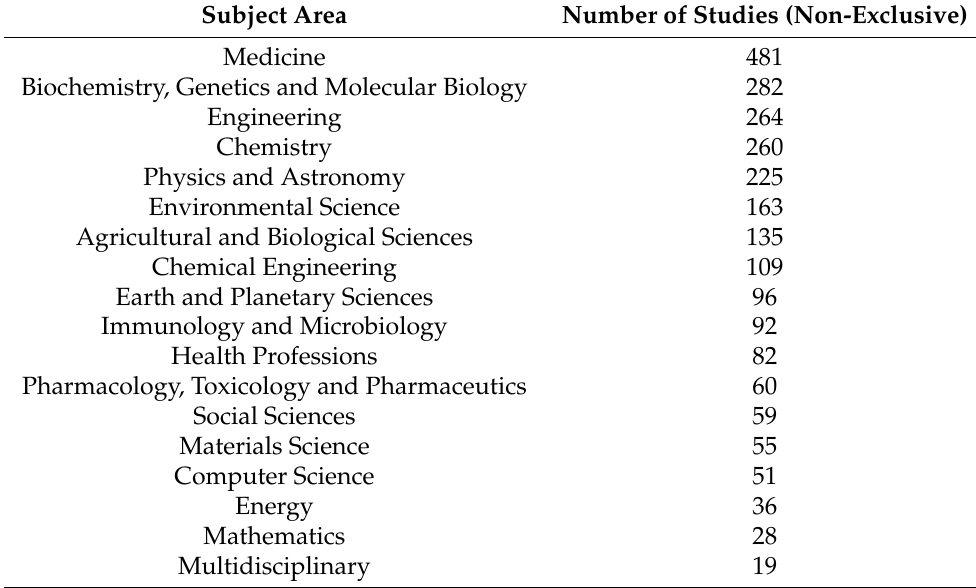
Table 1. Returned articles grouped by subject area according to Scopus